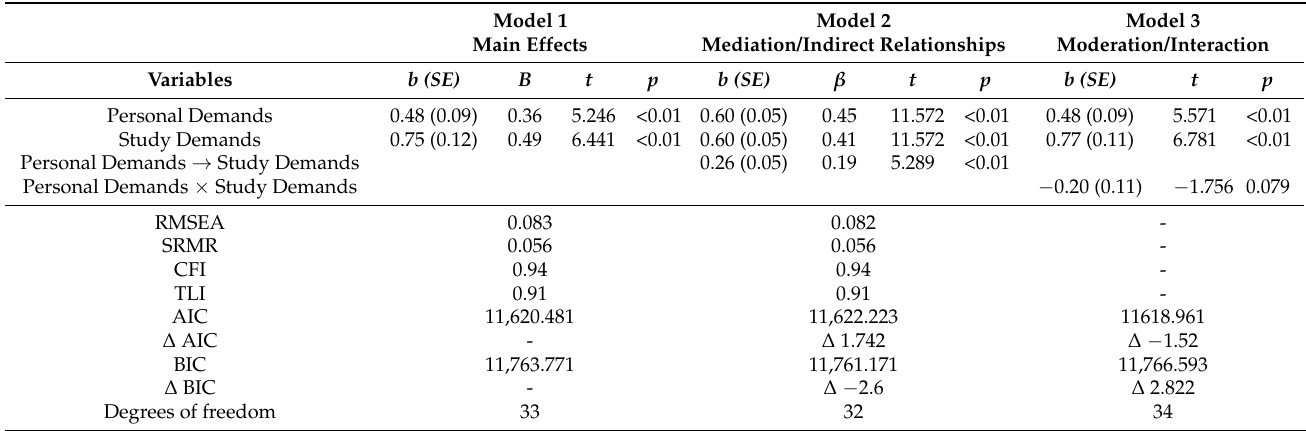
Table 2. Regression coefficients and fit indices for the main effects model, the mediation model, and the moderation model with burnout as dependent variable ( n =